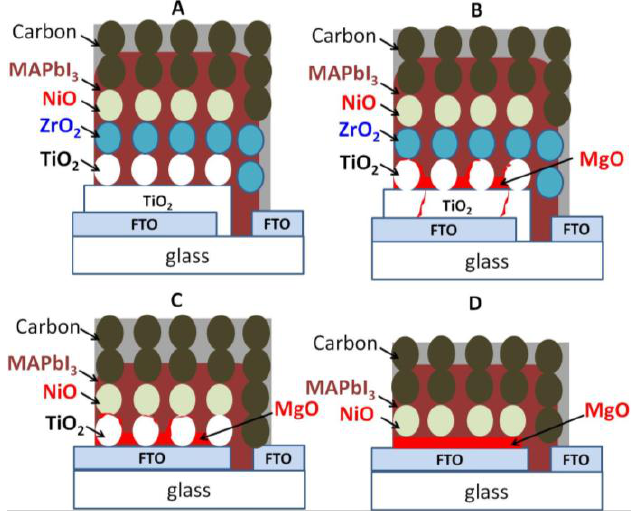
Figure 1. Different printable perovskite solar cell structures; ( A ) FTO/TiO 2 /ZrO 2 /NiO/Carbon(MAPbI 3 ); ( B ) FTO/TiO 2 <MgO>/ZrO 2 /NiO/Carbon(MAPbI 3 ); ( C ) FTO/TiO 2 <MgO>/NiO/Carbon(MAPbI 3 ) and ( D ) FTO/MgO/NiO/Carbon(MAPbI 3 ).